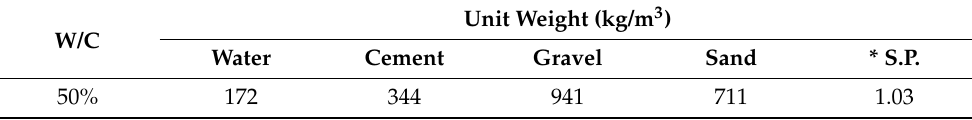
Table 2. Mix proportion of